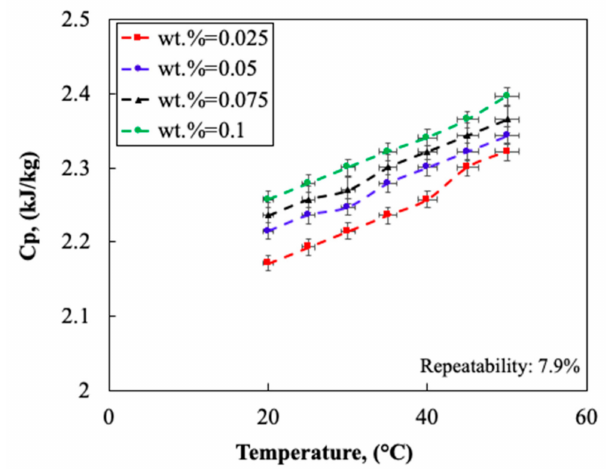
Figure 9. Dependence of heat capacity of nanofluids on temperature for various concentrations of CNPs in